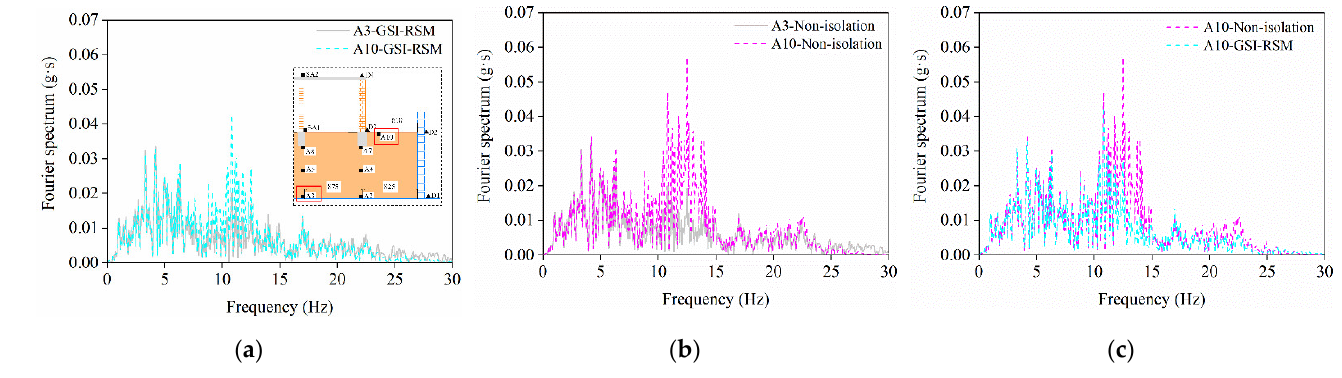
Figure 16. Fourier spectrum of measuring points: ( a ) GSI–RSM test; ( b ) non-isolation test; ( c ) comparison between non-isolation test and isolation test.